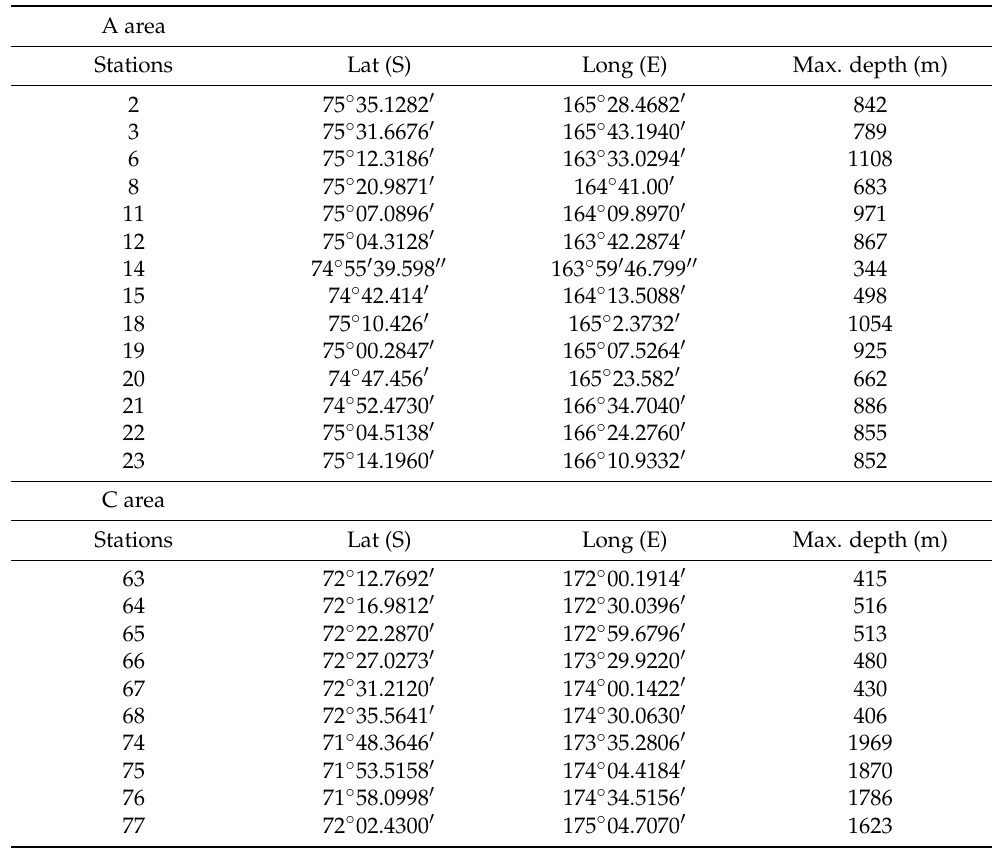
Table 1. Geographical coordinates of the stations sampled in Ross